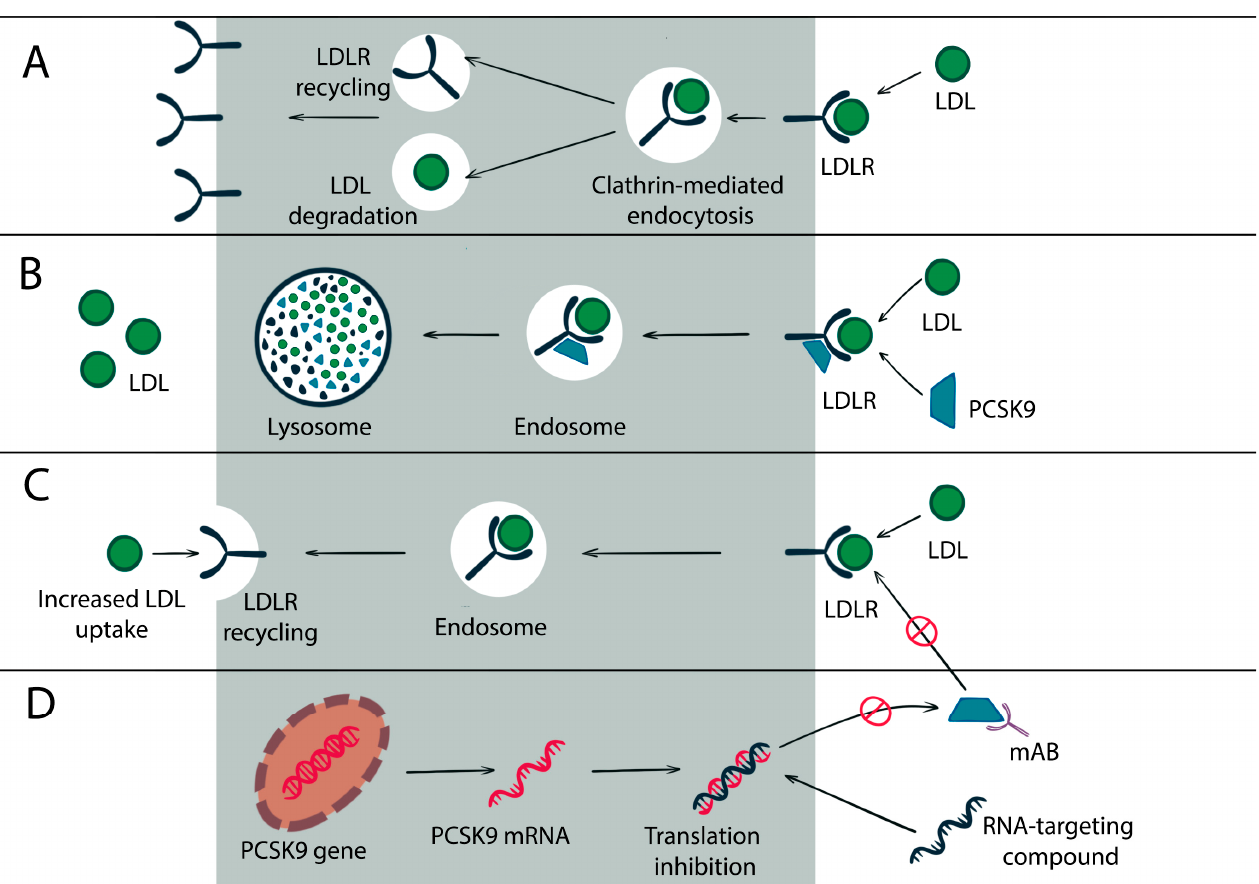
Figure 1. PCSK9 and LDLR. Panel ( A ): the LDLR–LDL complex internalization into endosomes through a clathrin-dependent mechanism. After that, LDLR is recycled to the cell surface. Panel ( B ): in the presence of PCSK9, the LDLR–LDL complex is internalized into endosomes, and then all parts are degraded in lysosome. Panel ( C ): in the presence of mAB, LDLR is internalized and then recycled to the cell surface. Panel ( D ): the RNA-targeting compound binds to PCSK9 mRNA and prevents its translation. and prevents its